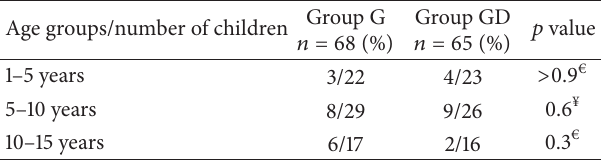
Table 4: Incidence of postoperative vomiting (1–5yrs) and postop- erative nausea and vomiting (PONV)